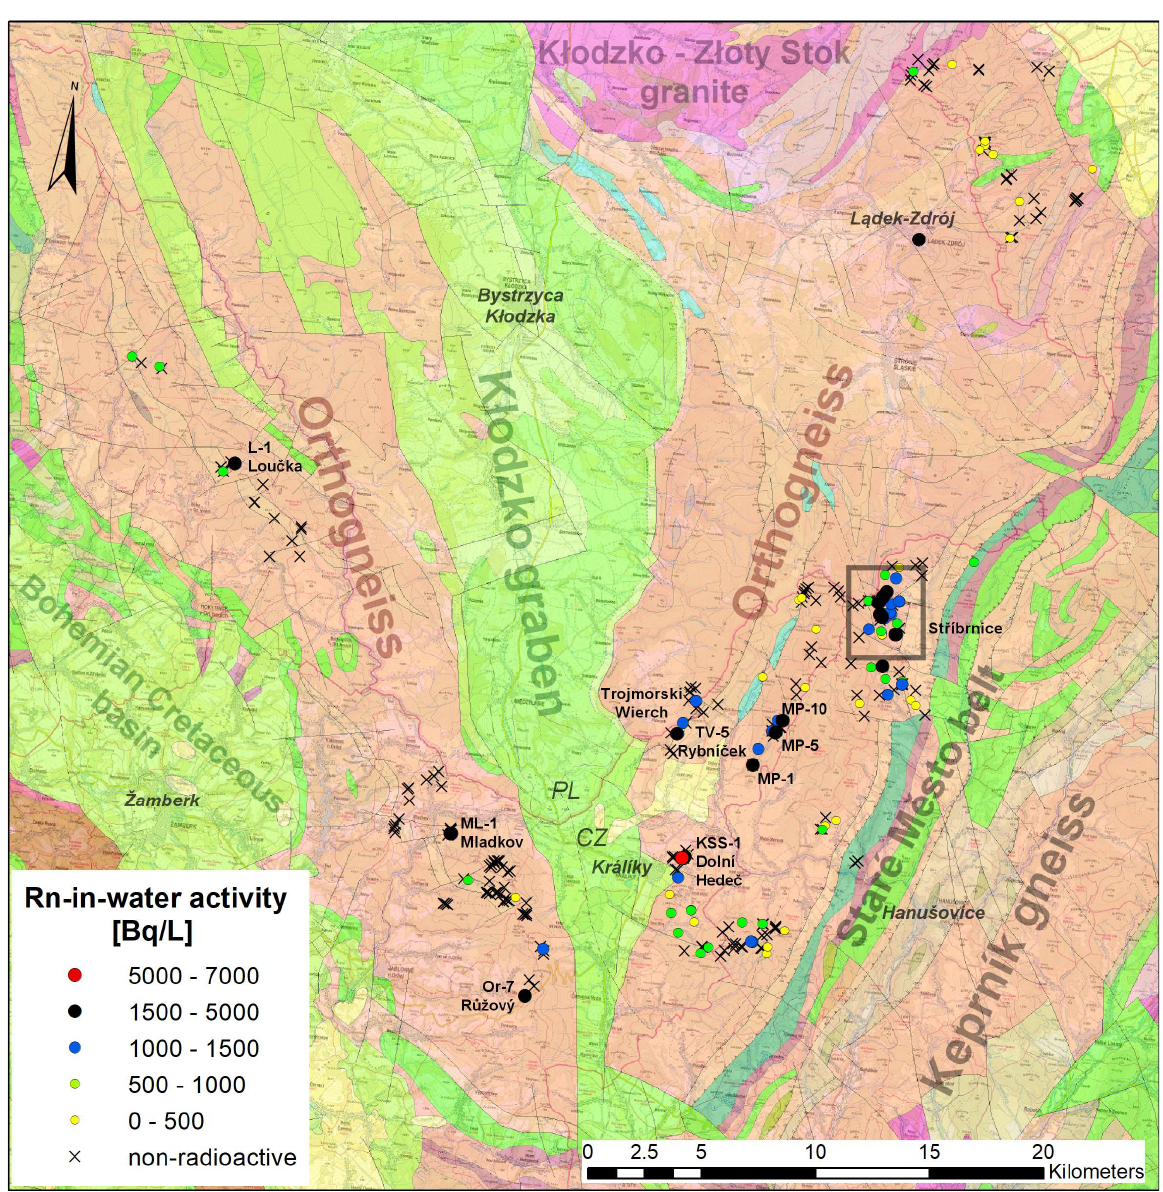
Figure 5. Radon-in-water activities in the Orlice–Sněžník dome, Claim #1. GIS composite. In the western part, a historically known spring is located at Mladkov [58]. The most active of the inflows had up to 1668 Bq/L [59]; but since 2016, the captured water hardly reaches 1500 Bq/L 222 Rn due to the interventions by the local municipality’s faulty field collection system. Many other important sources were found in the eastern part of the dome [59]. The small cluster of four sources close to the village of Doln í Hedeˇc near Kr á l í ky town, straight on the edge of the Kłodzko graben is significant. Here, exists the most active source of the whole Claim #1, overflowing borehole KSS-1 with an activity up to 5175 Bq/L (Table 2). According to the preserved documentation, there is 10.5 m of Quaternary below which there is orthogneiss to a depth of 80 m. The ranges of 39–50